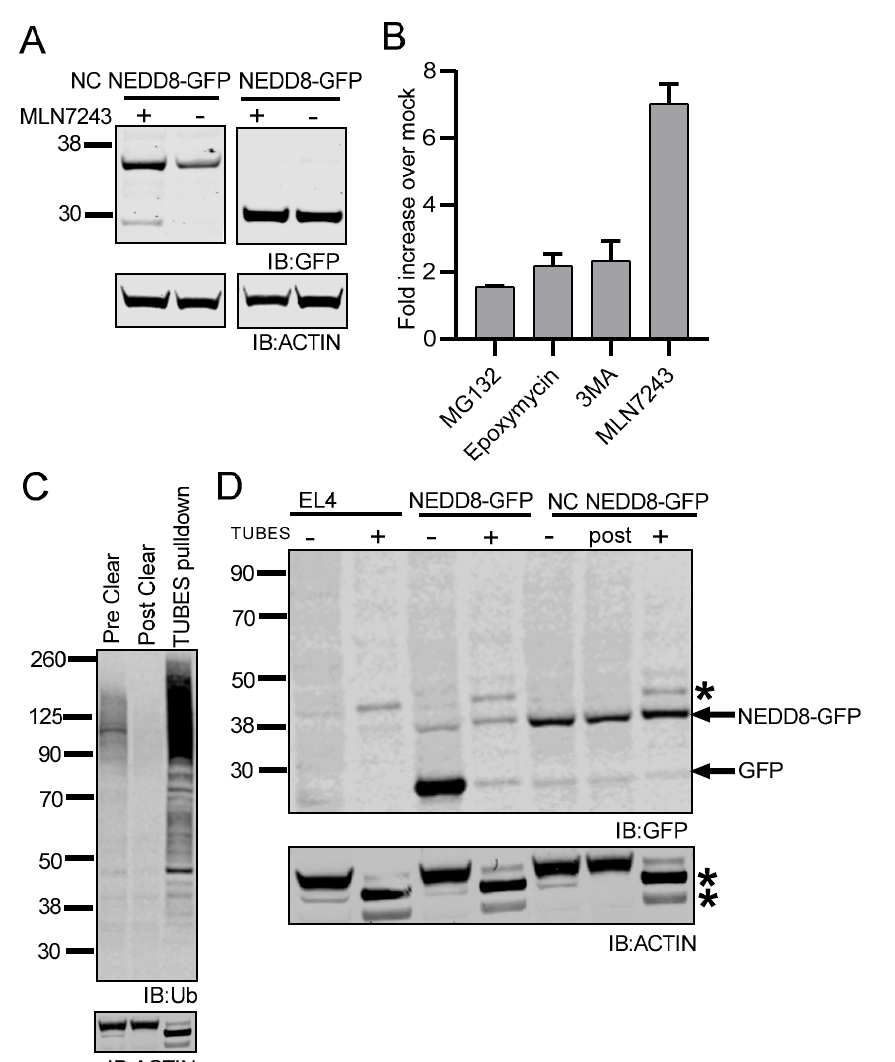
Figure 5. A functional ubiquitination system is required for NC NEDD8-GFP degradation. ( A ) EL4/NC NEDD8-GFP and EL4/NEDD8-GFP cells were treated with MLN7243 for 3 h to inactivate UBE1 preventing ubiquitination. Lysates were subjected to Western blot analysis for indicated proteins. ( B ) Western blot densitometry for GFP accumulation after treatment with MG132, Epox- omicin, 3MA, and MLN7243. GFP accumulation is shown as a fold increase over mock-treated cells. Values for MG132, Epoxomicin, and 3MA are from Figures 3 and 4. ( C ) Western Blot analysis for poly-ubiquitinated proteins in EL4/NC NEDD8-GFP lysates prior to TUBES precipitation (labeled pre-clear), post-pull down (labeled post clear), and the TUBES precipitated proteins. Poly- ubiquitinated proteins were identified by staining with the ubiquitin-specific monoclonal antibody FK2. Actin (bottom panel) is shown as a control. ( D ) Poly-ubiquitinated proteins were isolated from EL4, EL4/NEDD8-GFP, and EL4/NC NEDD8-GFP cell lysates using TUBES and subjected to Western blot analysis with GFP monoclonal antibodies. Total cell lysates not subject to TUBES pull-down (labeled “-“) were compared to proteins eluted from TUBES (labeled “+”) and, in the case of NC NEDD8-GFP cell lysates, the remaining total cell lysate after removing poly-ubiquitinated proteins (labeled “post”). Bands corresponding to GFP and NC NEDD8-GFP are indicated. Bands marked by an asterisk (*) are contaminating bands reacting non-specifically to the presence of an antibody. All Western blot images were cropped to show relevant bands.